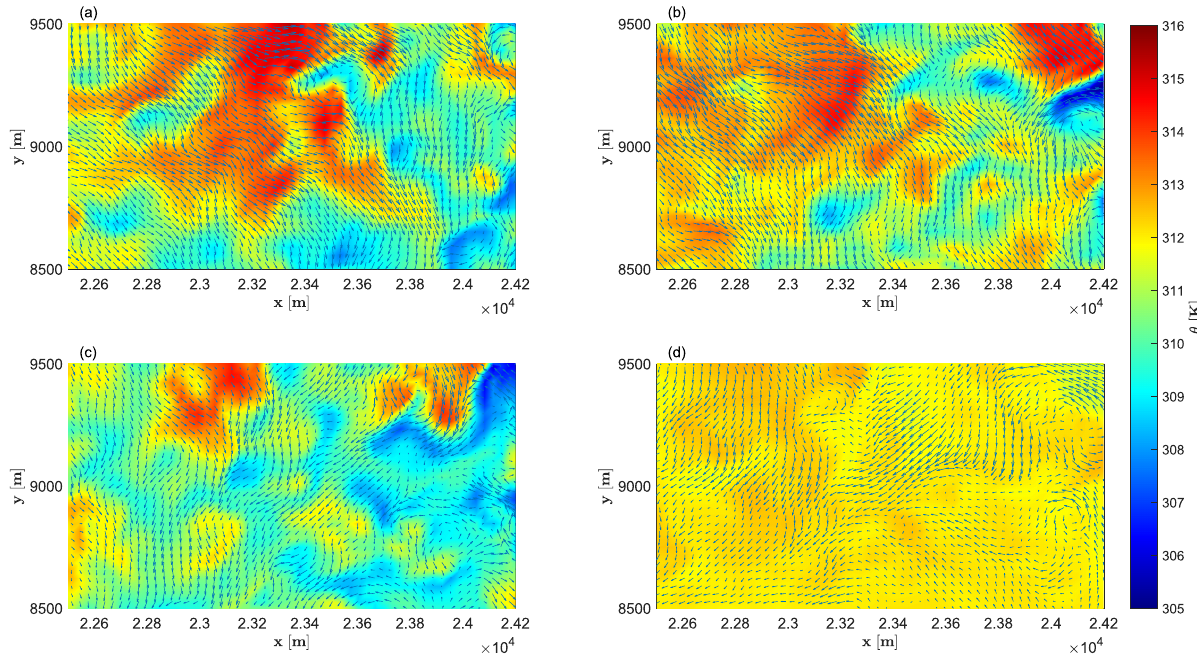
Figure 15. Instantaneous x-y cross-sections of potential temperature and horizontal flow fields (vector plots) at ( a ) UTC 09:00, ( b ) UTC 09:10, ( c ) UTC 09:20 and ( d ) UTC 09:30 at the altitude of 3200